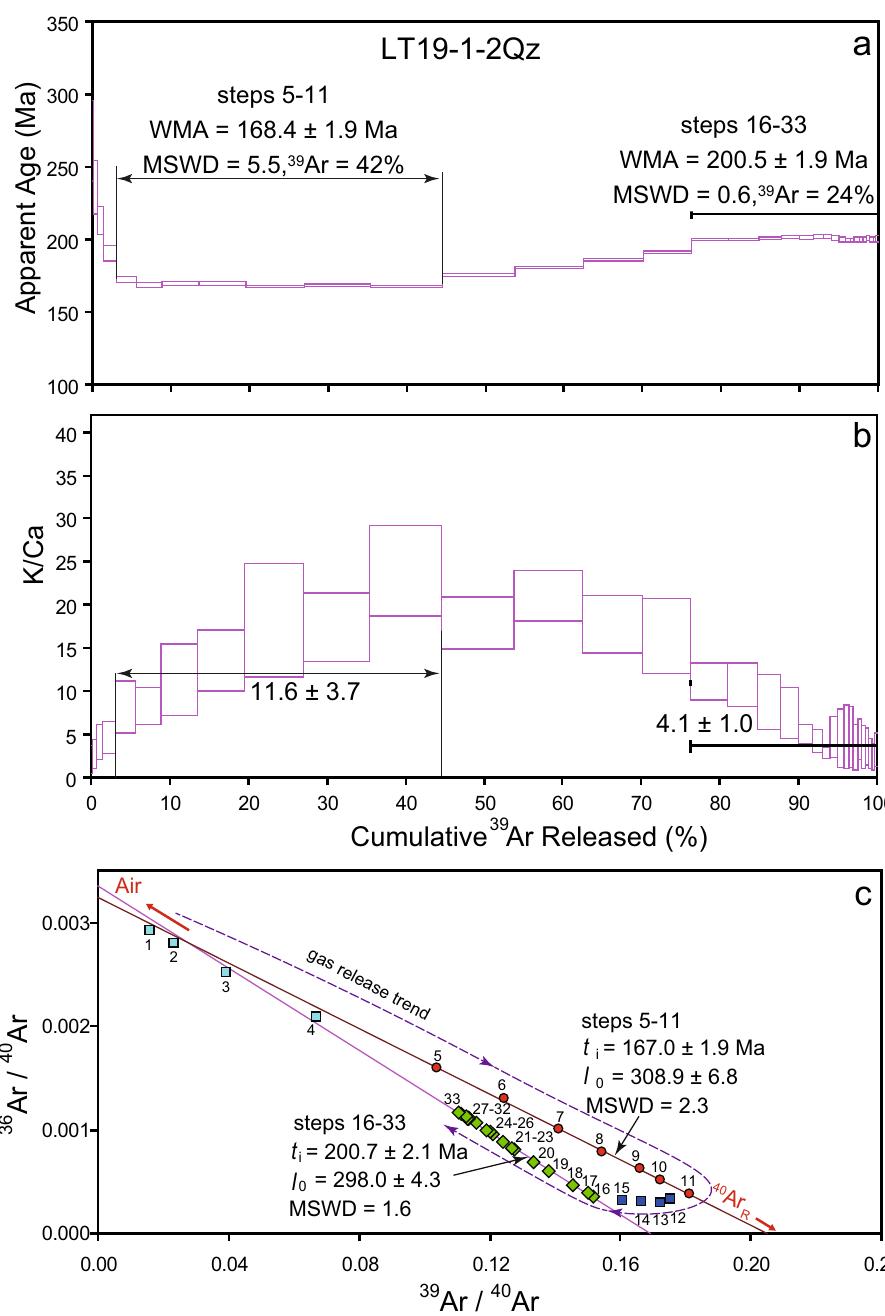
Figure 5. Plots based on the 40 Ar/ 39 Ar data of the quartz vein from the Liaotun Carlin-type gold deposit by in vacuo progressive crushing. ( a ) Age spectrum; ( b ) K/Ca spectrum; ( c ) inverse isochron. Data points through crushing (marked as 1 to 33) yield a clockwise trend, showing that radiogenic ( 40 Ar R ) and trapped argon in fluid inclusions and atmospheric argon (Air) from the crusher successively contribute to different parts of the